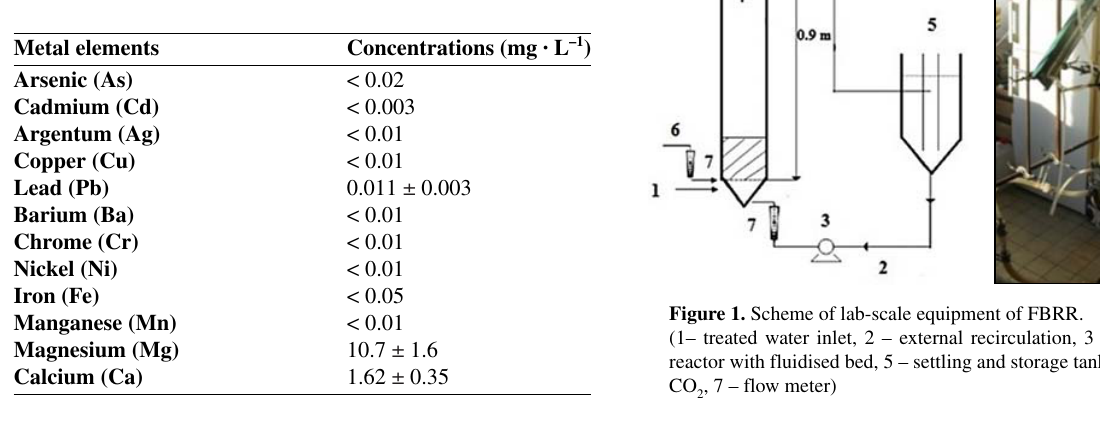
Table 1. Metal content (mg.L –1 ) in an aqueous extract of half-calci- ned dolomite.